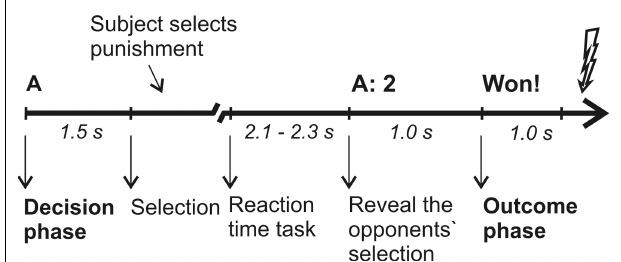
FIGURE 1 | Time line for a single trial. A trial of low provocation, in which opponent A selects 2, is shown as example. The duration of the selection phase depended on the participants’ reaction time to make the selection. Intertrial interval were 2